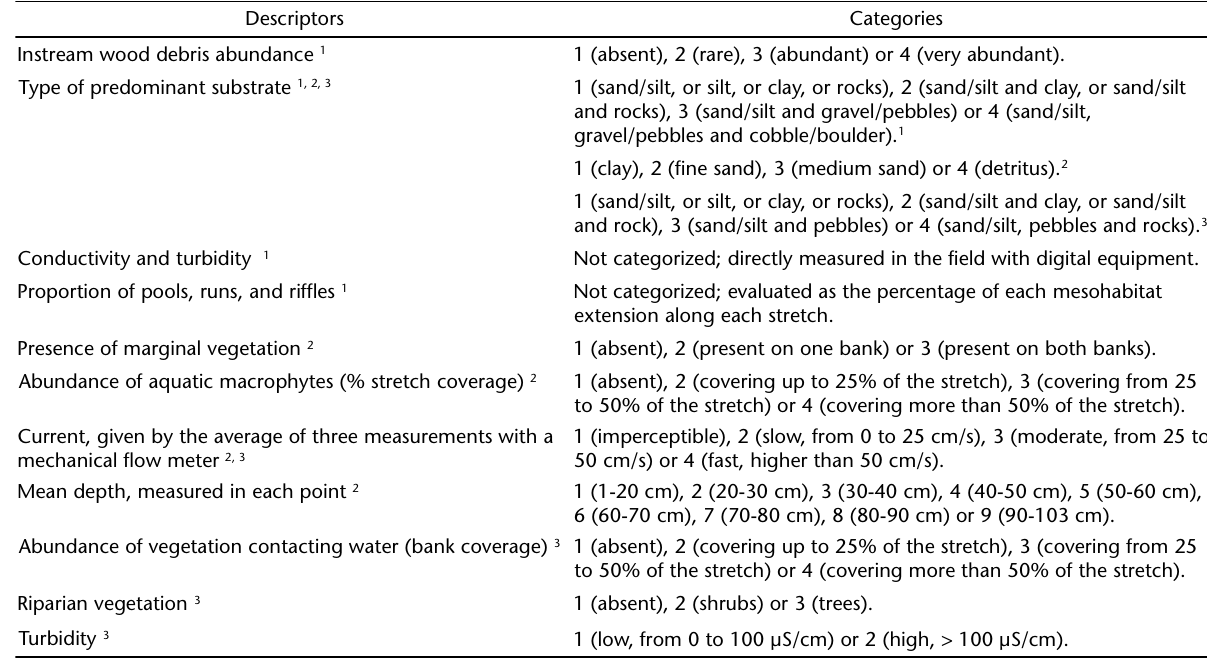
Table I. Environmental descriptors used in mesohabitat, microhabitat, and diet